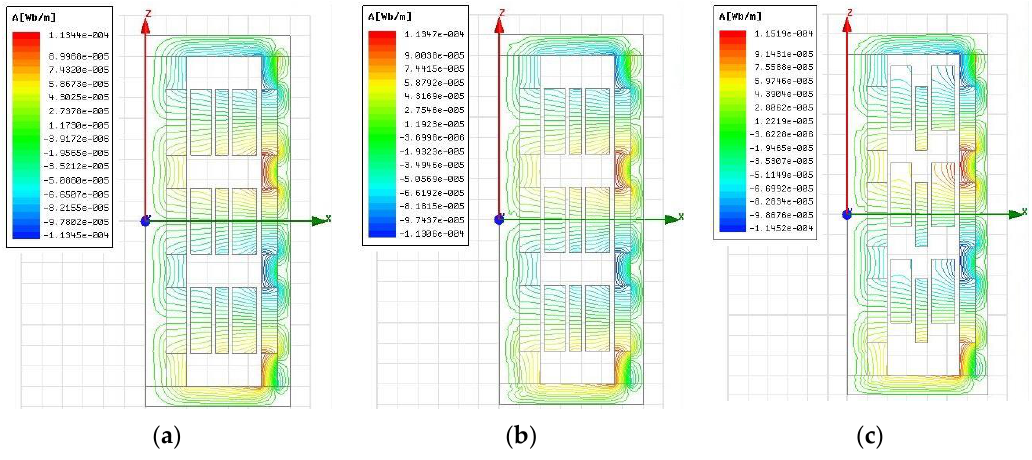
Figure 7. Magnetic flux distribution: ( a ) Initial position without power supply; ( b ) Initial position with power supply; ( c ) Maximum working position with power supply.